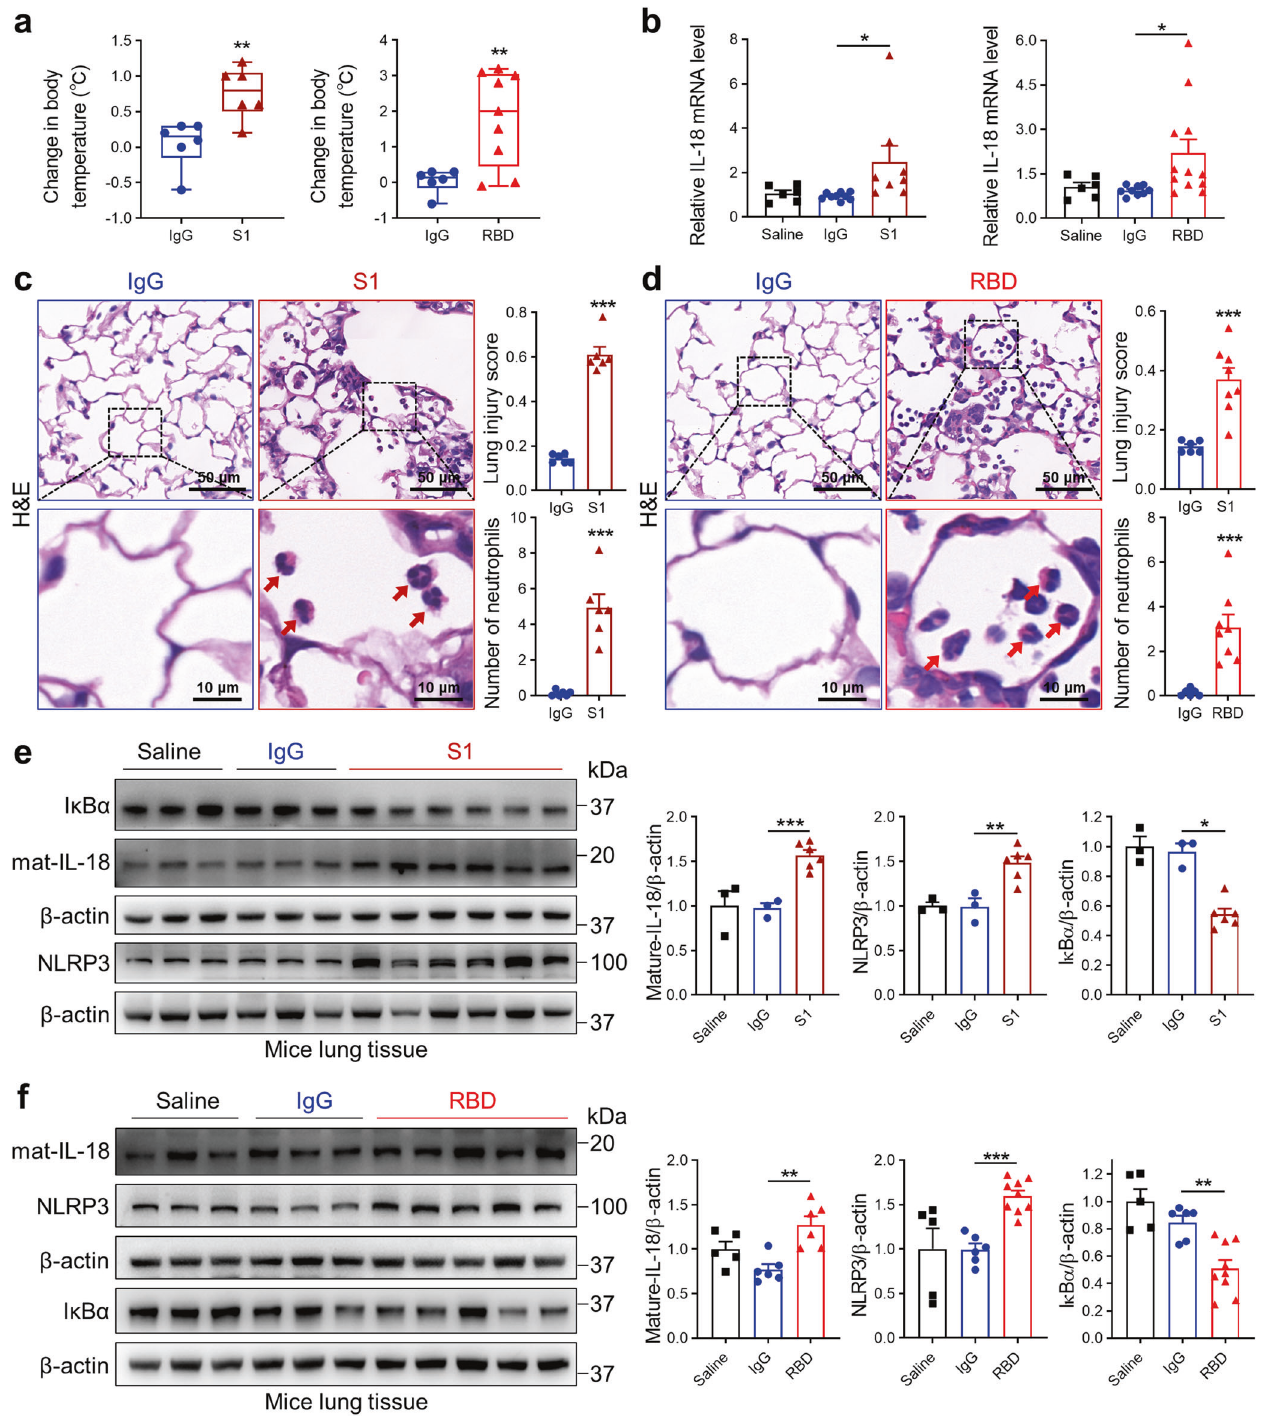
Fig. 2 Spike protein induces lung in fl ammation and IL-18 expression. Transgenic hACE2 mice were administered recombinant SARS-CoV-2 Spike S1 and RBD protein (5 μ g/mouse/d) for via tracheal intubation. After 10 days, mice were sacri fi ced. a Body temperature change is more in Spike protein-treated mice compared to IgG-treated mice (Student ’ s t -test, N = 6 – 9). b IL-18 gene expression levels are higher in the blood of Spike protein-treated mice (Student ’ s t -test). c , d Lung sections were examined by hematoxylin and eosin staining. Representative micrographs, neutrophil cell count and scored for lung injury are shown (Student ’ s t -test, N = 6 – 8). Red arrows suggest neutrophils. e , f Representative western blots and quanti fi cations of I κ B α (Student ’ s t -test), IL-18 (Student ’ s t -test) and NLRP3 (Student ’ s t -test) in lung tissues from saline-, IgG- and RBD/S1 protein-treated mice ( N = 3 – 9). Data indicate mean ± SE. * p < 0.05, ** p < 0.01, *** p < 0.001 relative to IgG exposure